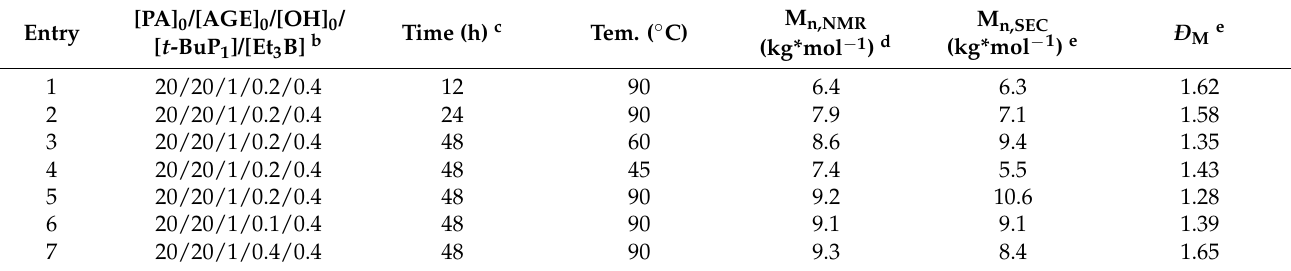
Table 1. Copolymerization Results of PA with AGE initiated by mpeg-OH catalyzed by TEB and t -BuP 1 a